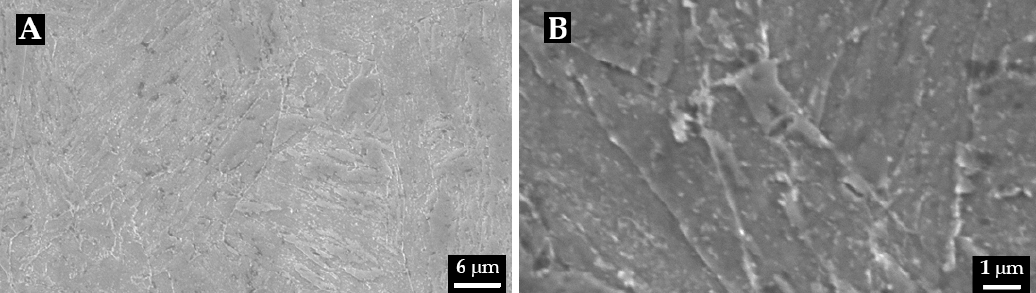
Figure 5. SEM micrographs of the sample quenched and tempered at 590 °C for 6 h at low magnification ( A ) and higher magnification ( B ). Figure 6. SEM micrographs of the sample quenched and tempered at 590 °C for 10 h at low magnification ( A ) and higher magnification ( B ).